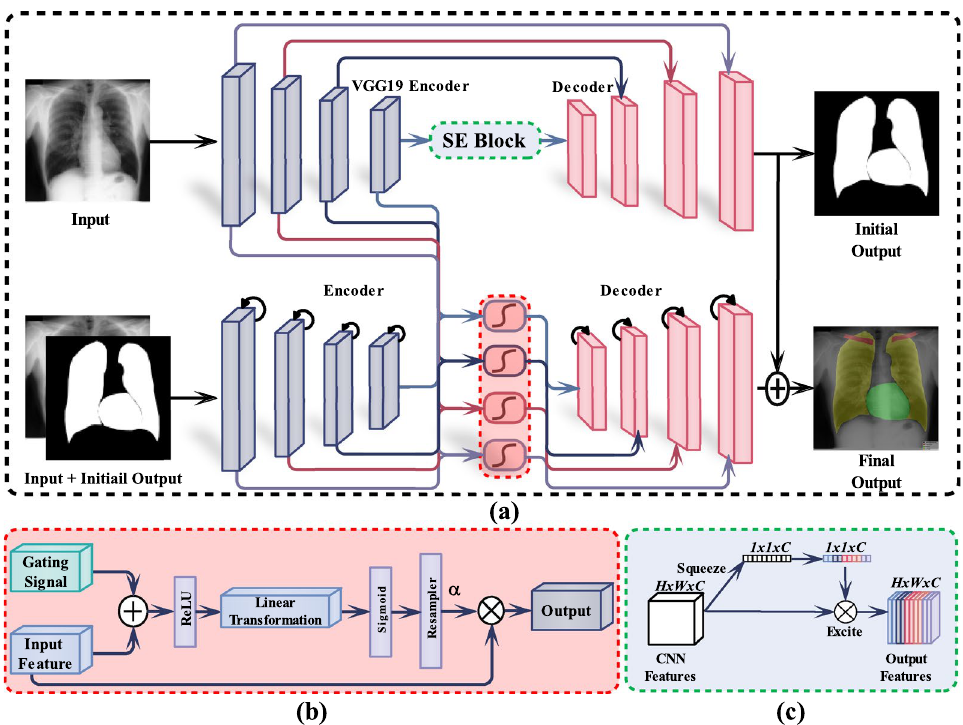
Figure 1. ( a ) The overall architecture of the proposed anatomical structures segmentation in the X-ray images, and ( b ) illustrates the attention-gating module in the red dotted lines. The attention coefficients computed in the AGM are used to scale the input features. The gating signal in the AGMs uses both the activations and the contextual information to identify the spatial regions. ( c ) The Squeeze-and-Excite (SE)